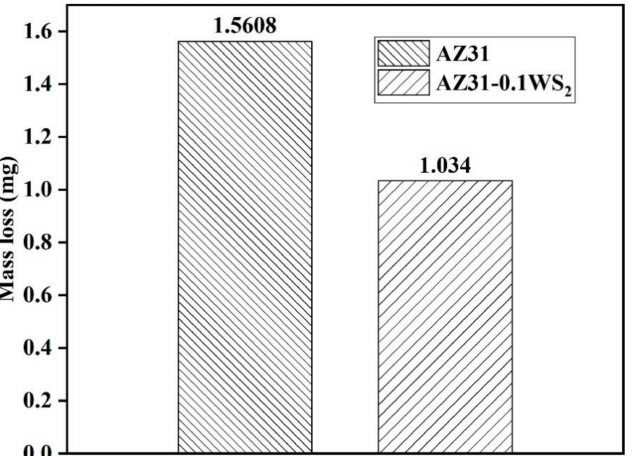
Figure 4. Wear behavior of wear weight loss of the fabricated AZ31/ WS 2